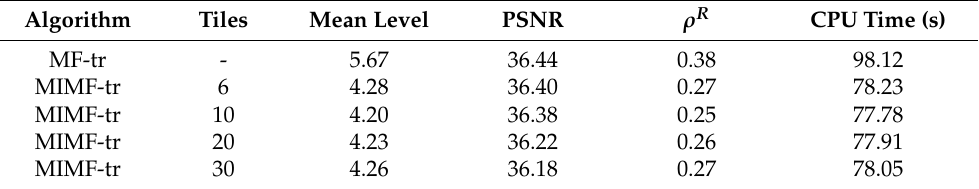
Table 2. Mean levels, PSNR, mean compression rate, and CPU times for the source image in Figure 5a.